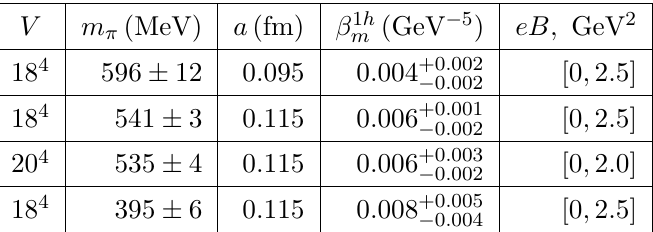
Table 5. The magnetic hyperpolarizability (cid:12) 1 h of the charged (cid:26) meson obtained from the 2- m parametric (cid:12)t (4.2), where we use the data from table 1 and table 4. The results are obtained for various lattice volumes V , lattice spacings a and pion masses m (cid:25) .